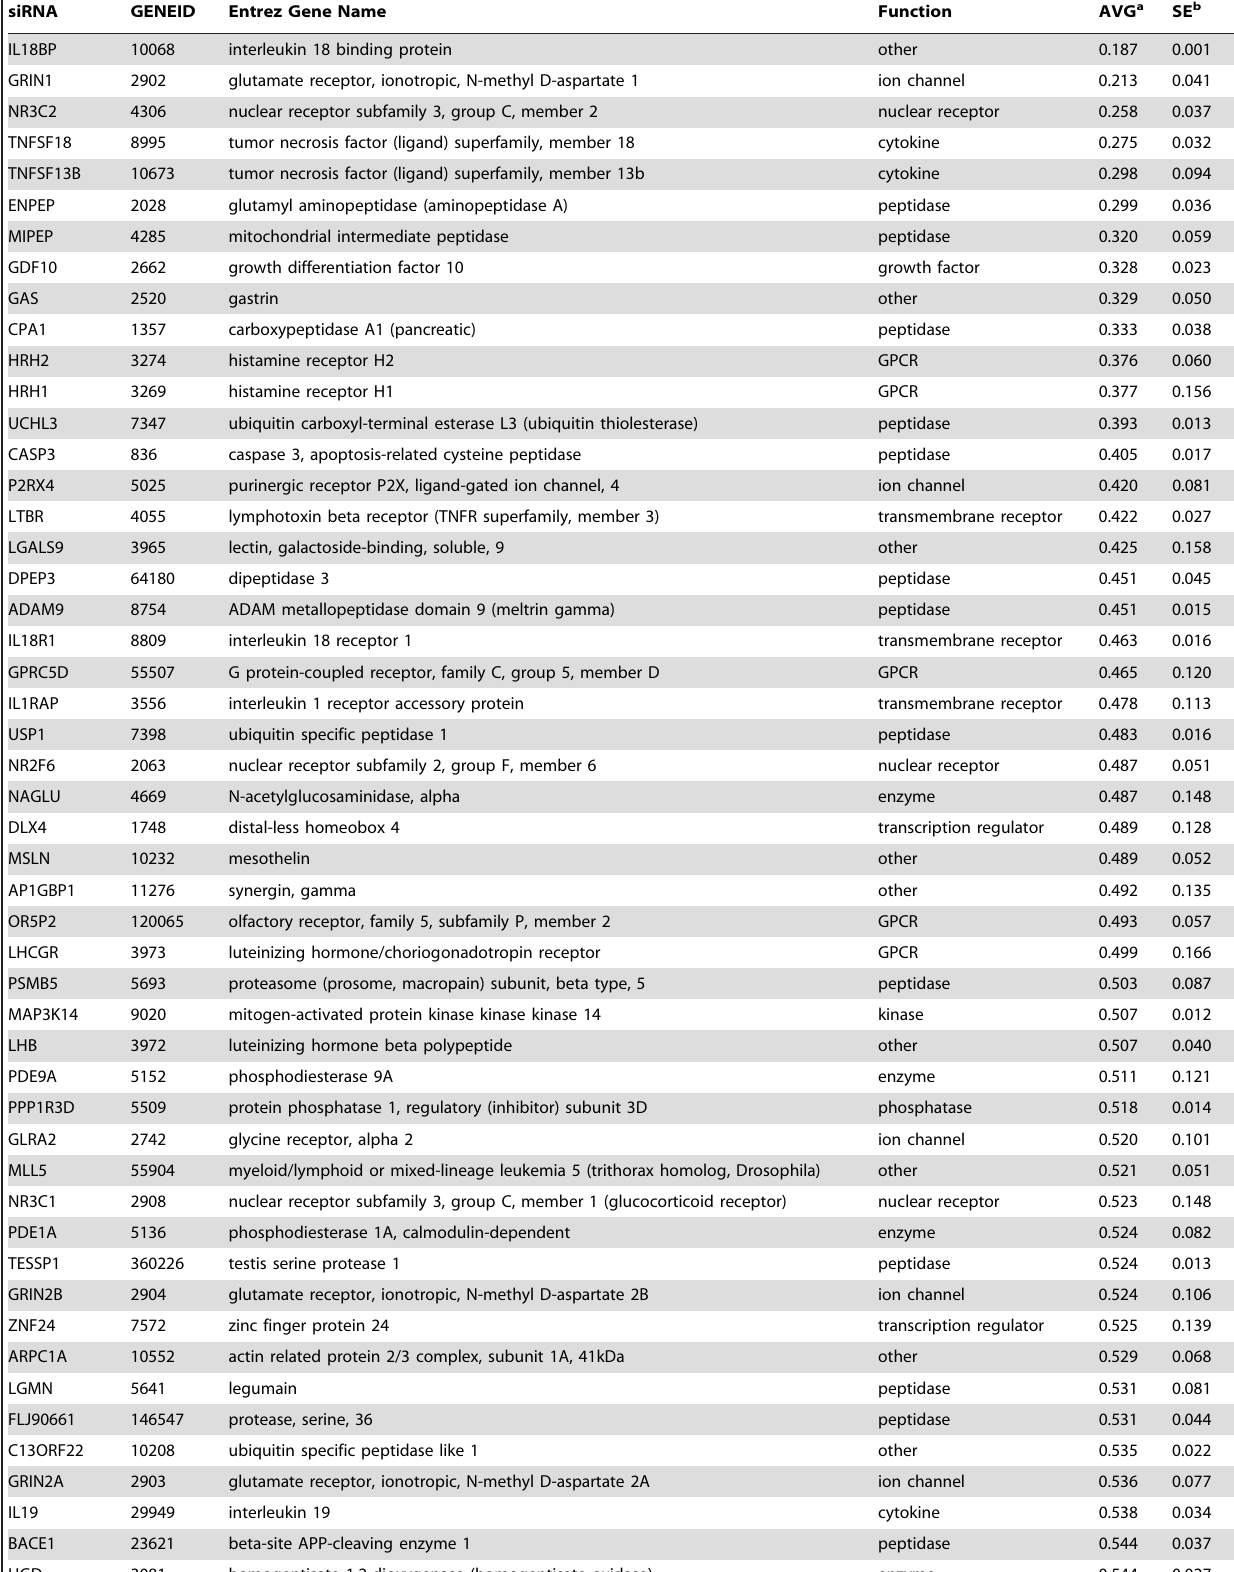
Table 1. List of